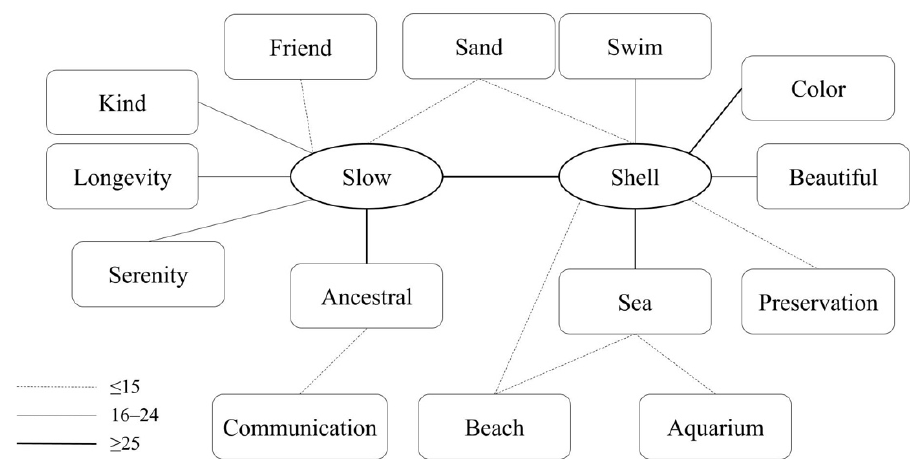
Figure 6. Tree with the elements of the social representation of turtles (total sample).